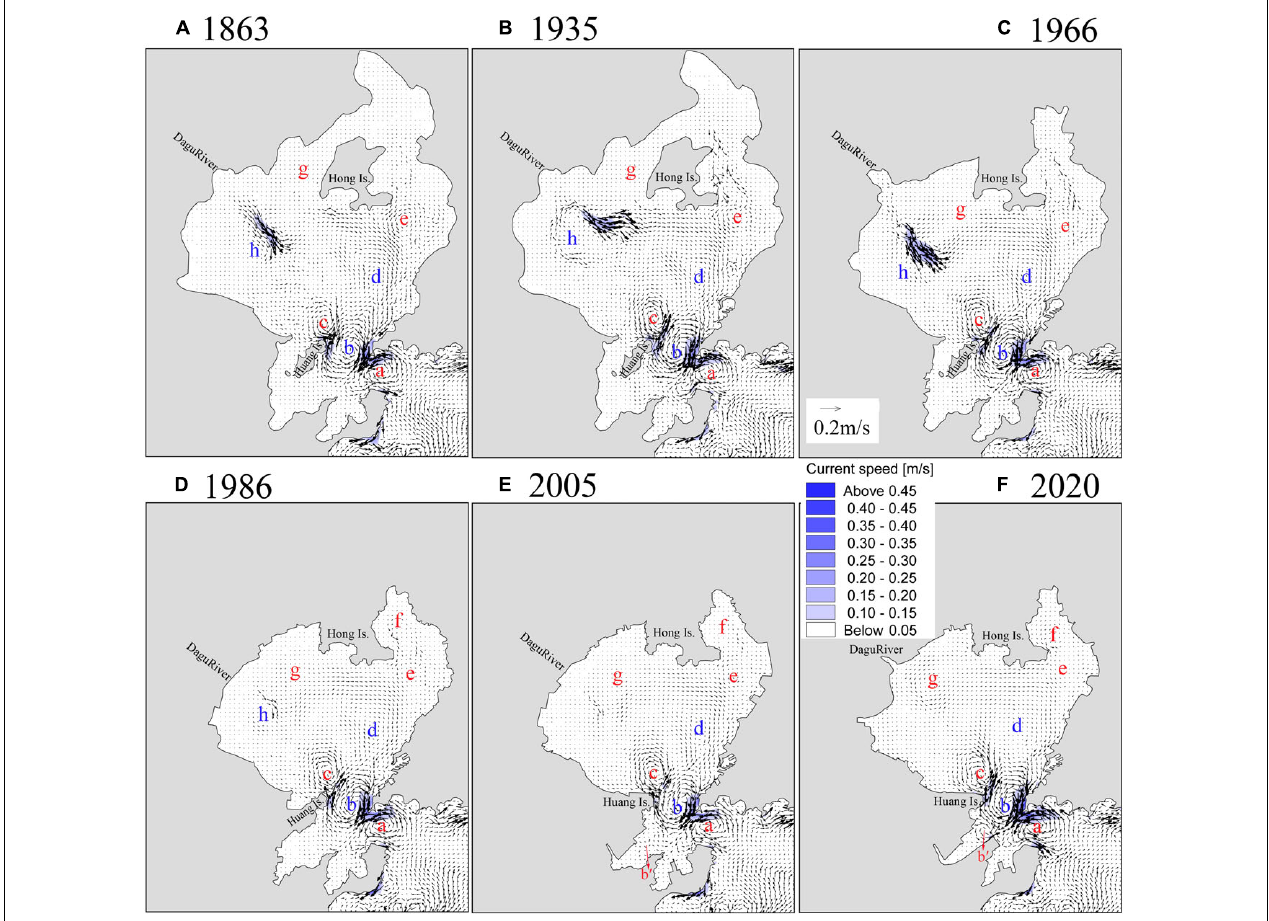
FIGURE 8 | Distributions of residual currents in (A) 1863 (B) 1935 (C) 1966 (D) 1986 (E) 2005 (F) 2020.